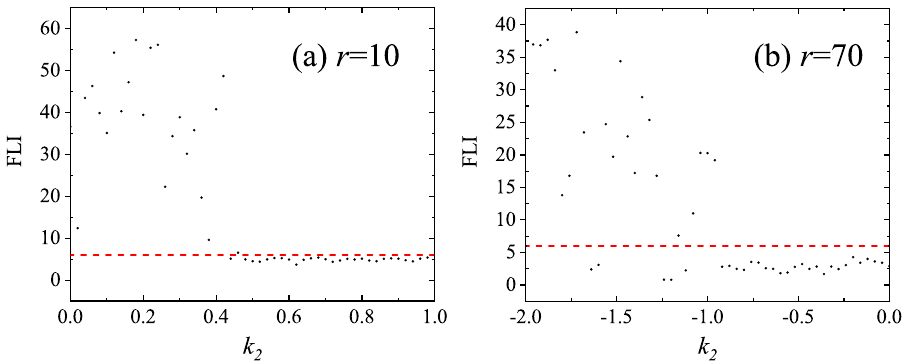
Figure 12. ( a ): Dependence of FLI on the positive deformation parameter k 2 in Figure 11a–c. The initial separation is r = 10. When k 2 > 0.46, chaos is absent. ( b ): Dependence of FLI on the negative deformation parameter k 2 in Figure 11d–f. The initial radius is r = 70. When k 2 < − 0.96, the chaotic properties are